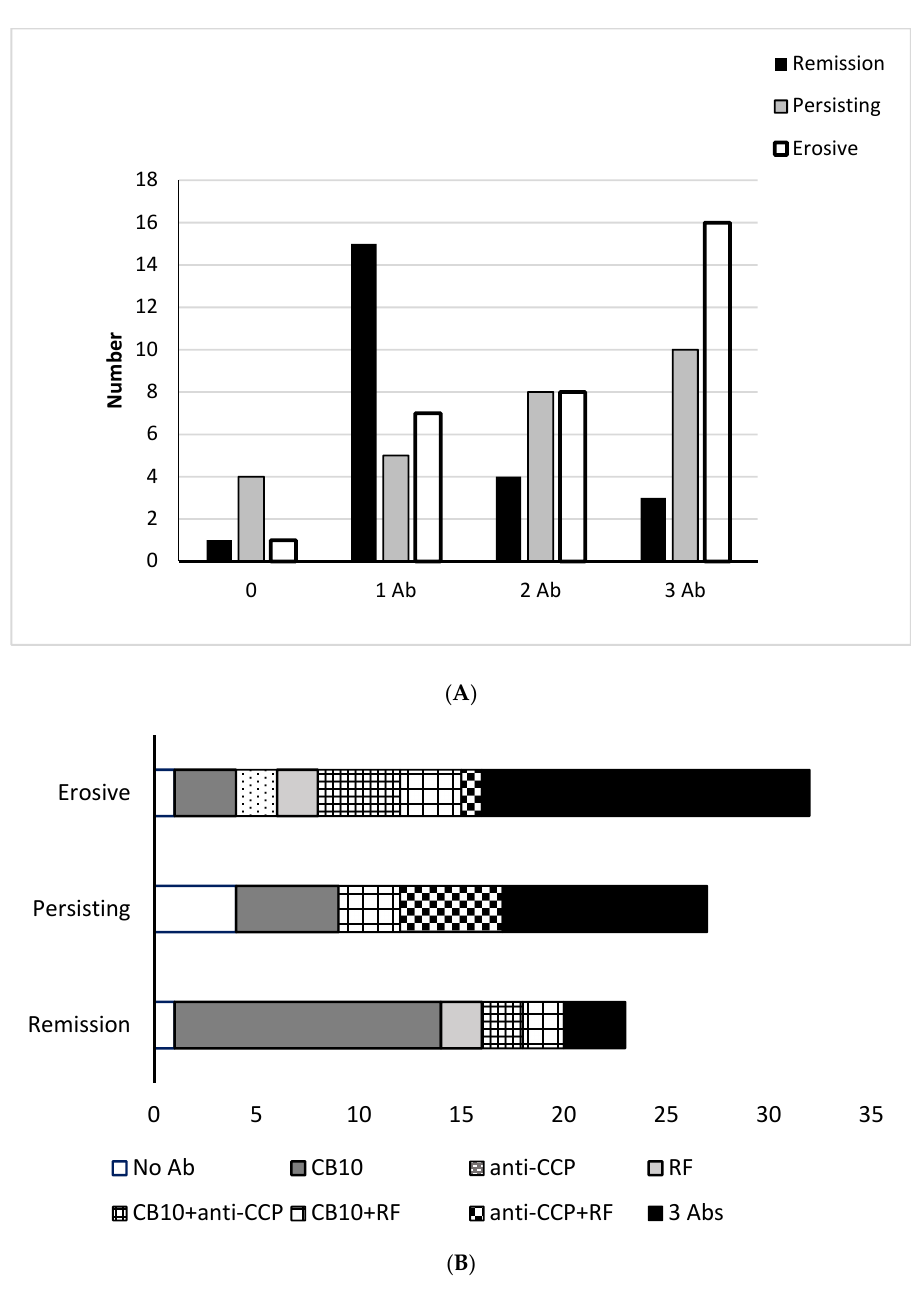
Figure 3. ( A ) Outcome in the 82 patients with early RA according to the number of autoantibodies detected initially; and ( B ) combinations of autoantibodies in the patients with early RA grouped according to outcomes.